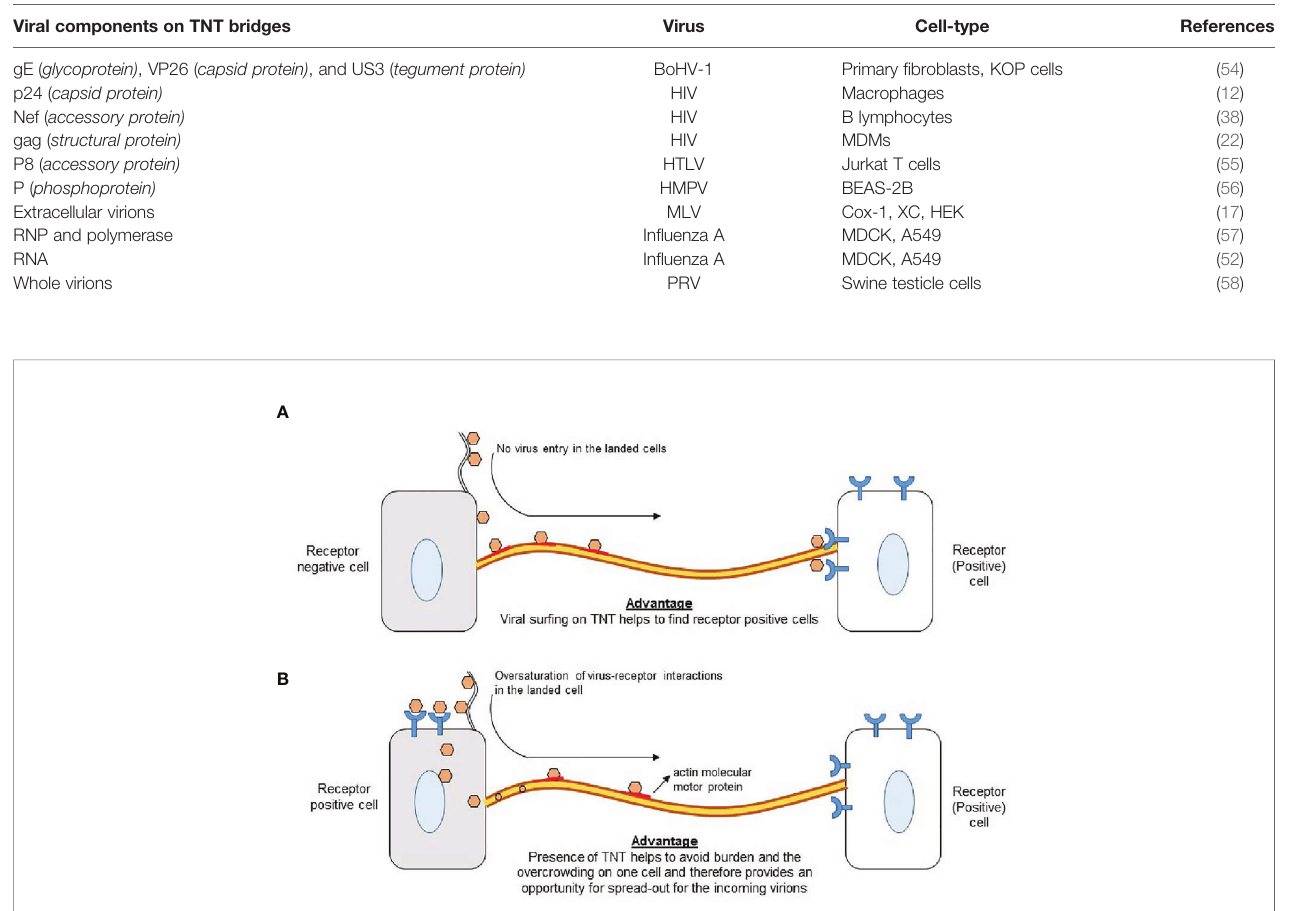
FIGURE 5 | Signi fi cance of TNTs to promote virus-cell interactions (A) Virus landing on receptor negative cells induces TNT bridges which aids in viral sur fi ng to fi nd the receptor positive cell for cell entry. (B) Virus landing on receptor positive cell results engagements of virus-cell interactions via receptor leaving an opportunity for the coming virions to use TNTs to fi nd the receptor positive cells for cell